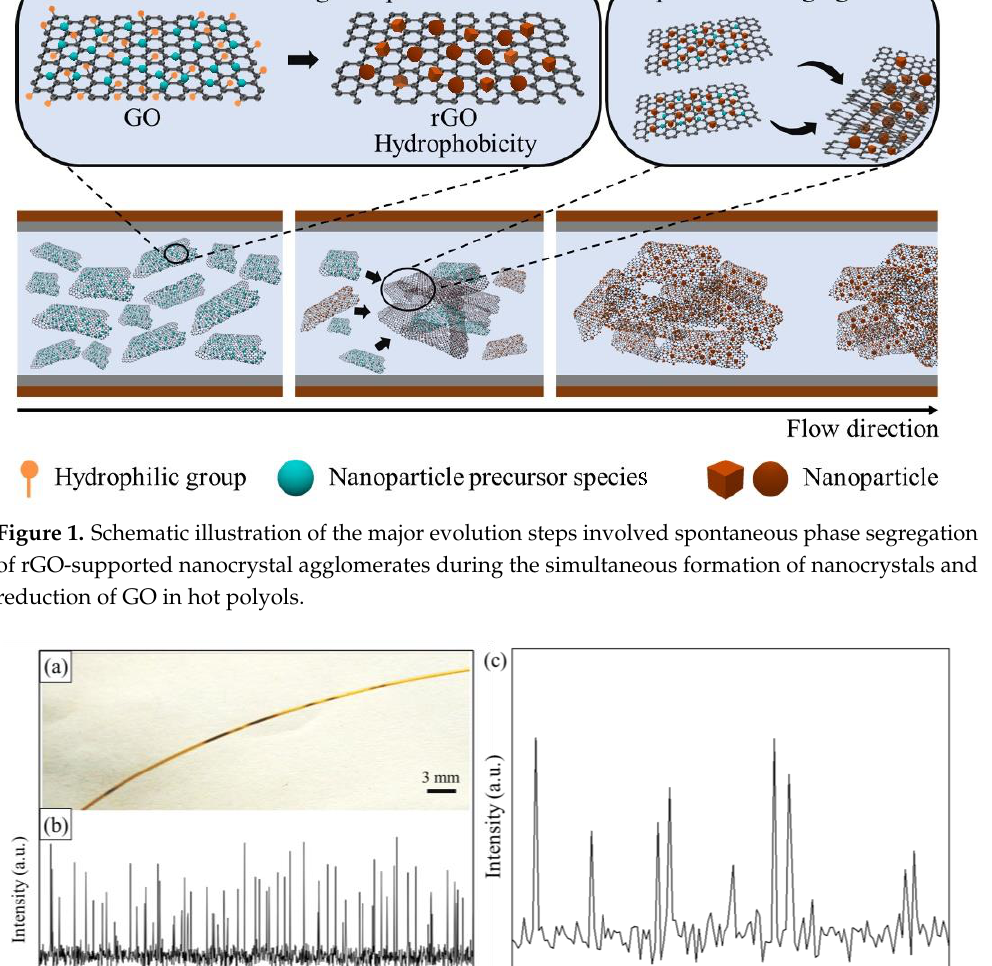
Figure 1. Schematic illustration of the major evolution steps involved spontaneous phase segrega- wall of the capillary tube. Forming the short rGO segments in TEG liquid is beneficial for continuous flow and prevents clogging of the microfluidic channel.